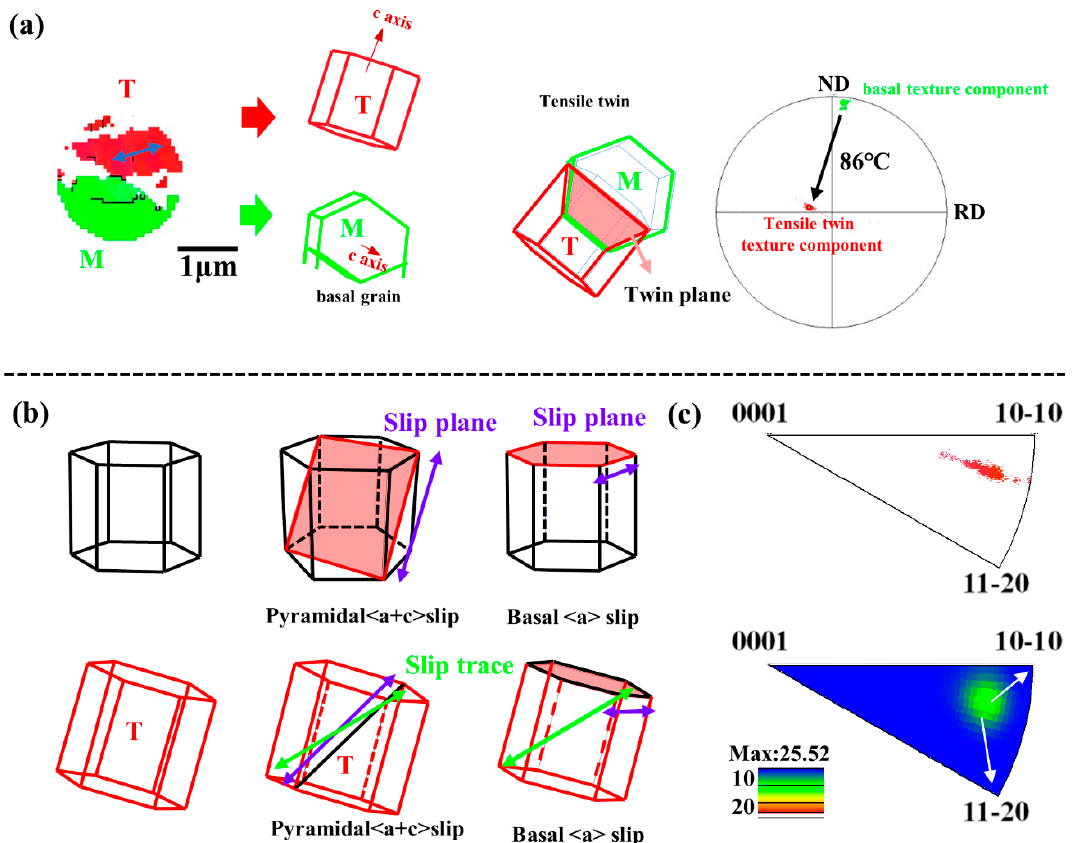
Figure 11. Plastic deformation mechanism of crack inhibition: ( a ) Twinning with an enlarged black circle in Figure 8f. ( b ) slip system. Purple arrows represent slip direction and green arrow represents slip plane trace, which is the same as the dislocation trace in Figure 8b. ( c ) In-grain misorientation axis (IGMA) analysis of T in Figure 11a.